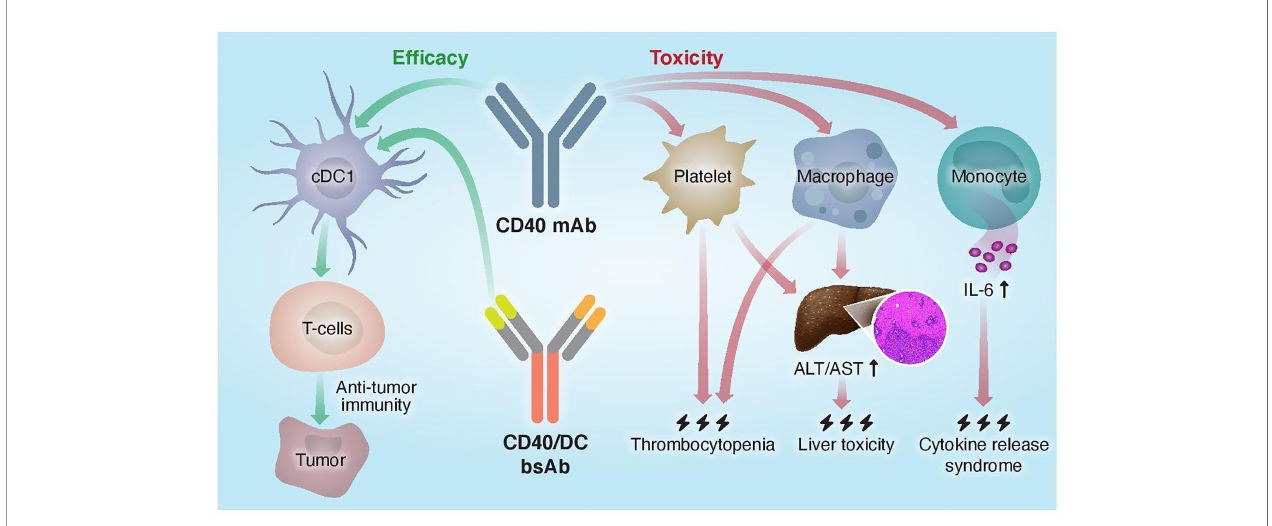
FIGURE 2 | Proposed mechanisms of mono- and bispeci fi c CD40 agonistic antibody activity. Traditional monoclonal anti-CD40 Abs do not distinguish between different CD40 + cells and activate both the ef fi cacy arm, driven by cDC1s, and the toxicity arm, driven by macrophages, platelets, and monocytes. CD40/DC bsAbs, which display preferred binding to and selective activation of DC populations, improved the therapeutic window of CD40-targeted immunotherapy by increasing antitumor immunity and reducing systemic